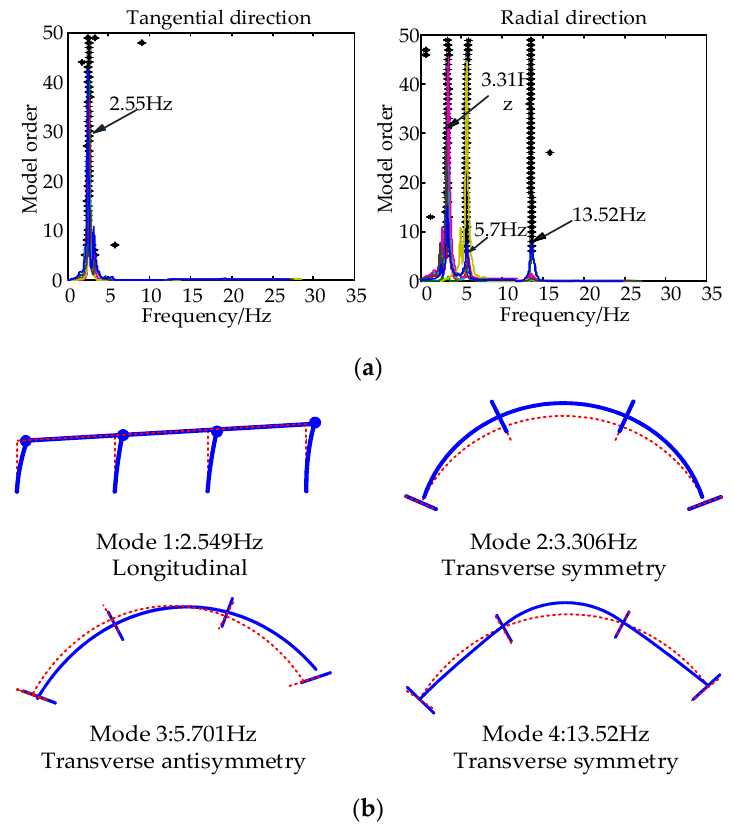
Figure 8. Identified frequencies and mode shapes of the bridge model: ( a ) stabilization diagram of the stochastic subspace identification (SSI) method; ( b ) identified natural frequencies and mode shapes.